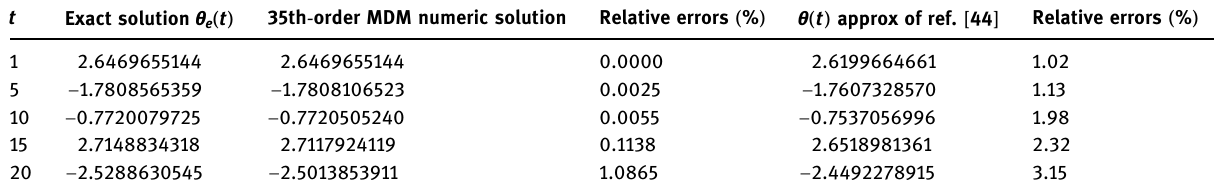
Table 1: Comparison of the 35th - order MDM numeric solution and the recent solution reported in ref. [ 44 ] with the exact solution for the case of Example